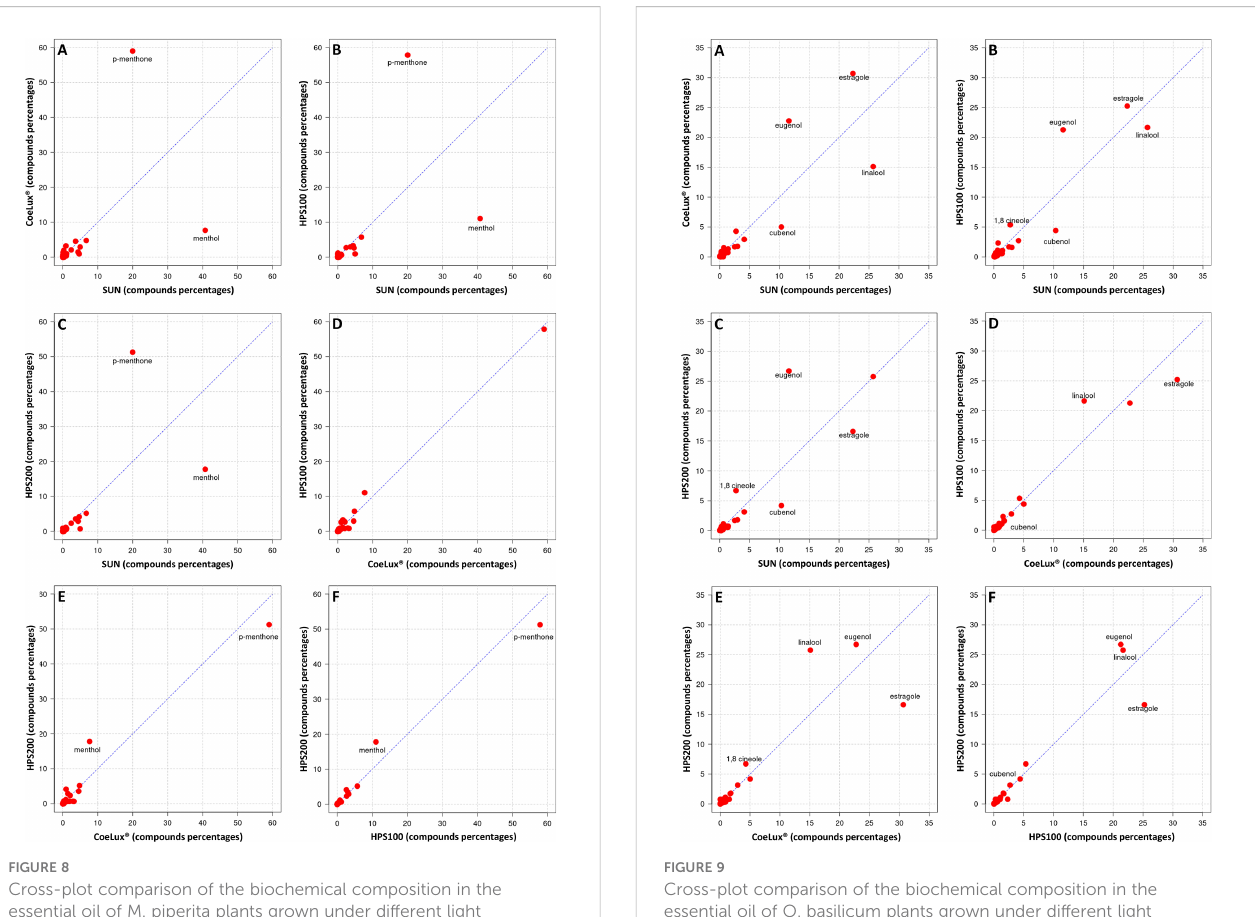
Multiple morphological changes were observed in response to the different light types and intensities, which underscored a slightly different response among the two plant species analyzed. M. piperita showed a general suppression of both above and belowground